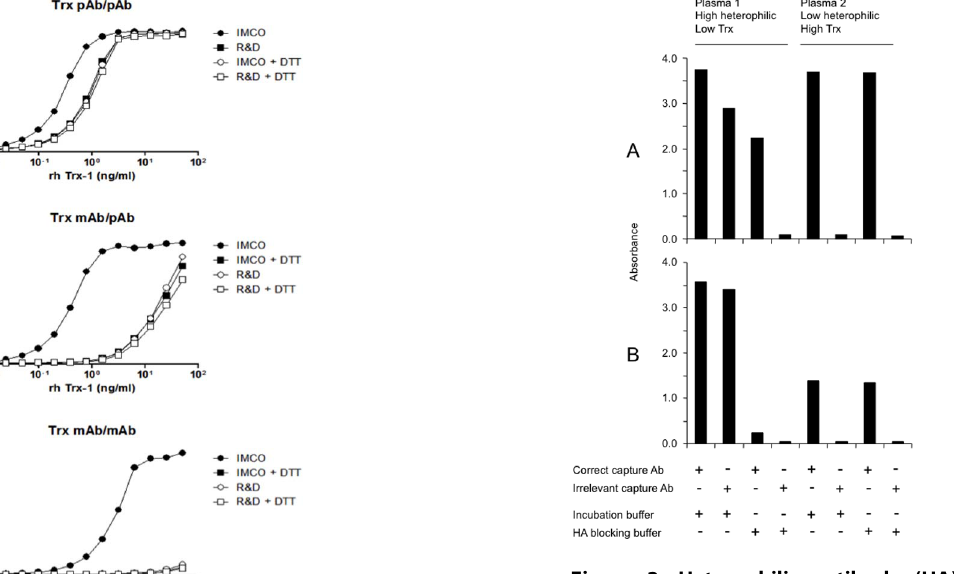
Figure 3. Heterophilic antibody (HA) interference in the different capture ELISA setups. Impact of HA on the detection of Trx1 in two human plasma samples. Two plasmas were diluted 5-fold in incubation buffer or HA blocking buffer and analyzed by Trx1 ELISA. A: analysis with pAb/pAb system where the capture pAb also was replaced by an irrelevant goat pAb. B: analysis with mAb/pAb system where the capture mAb also was replaced by an irrelevant mouse mAb. The experiment was repeated with similar